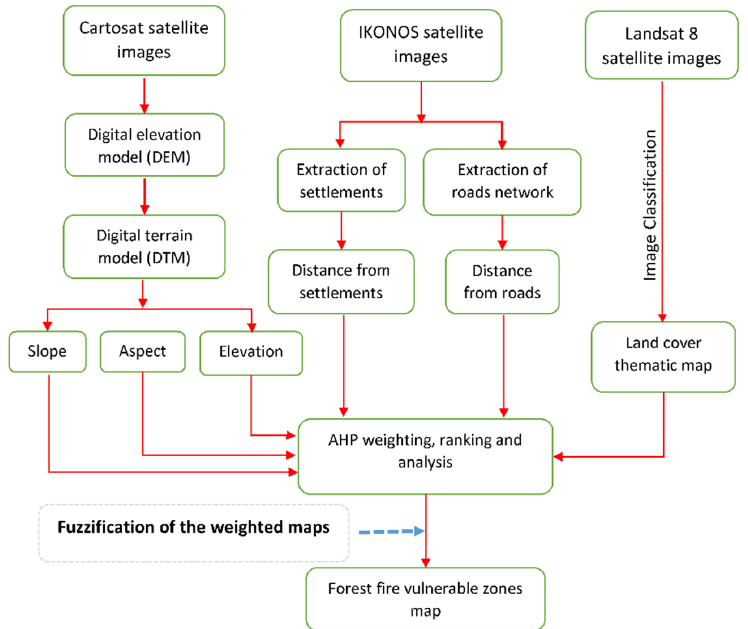
Fig. 2. A flow chart of the employed